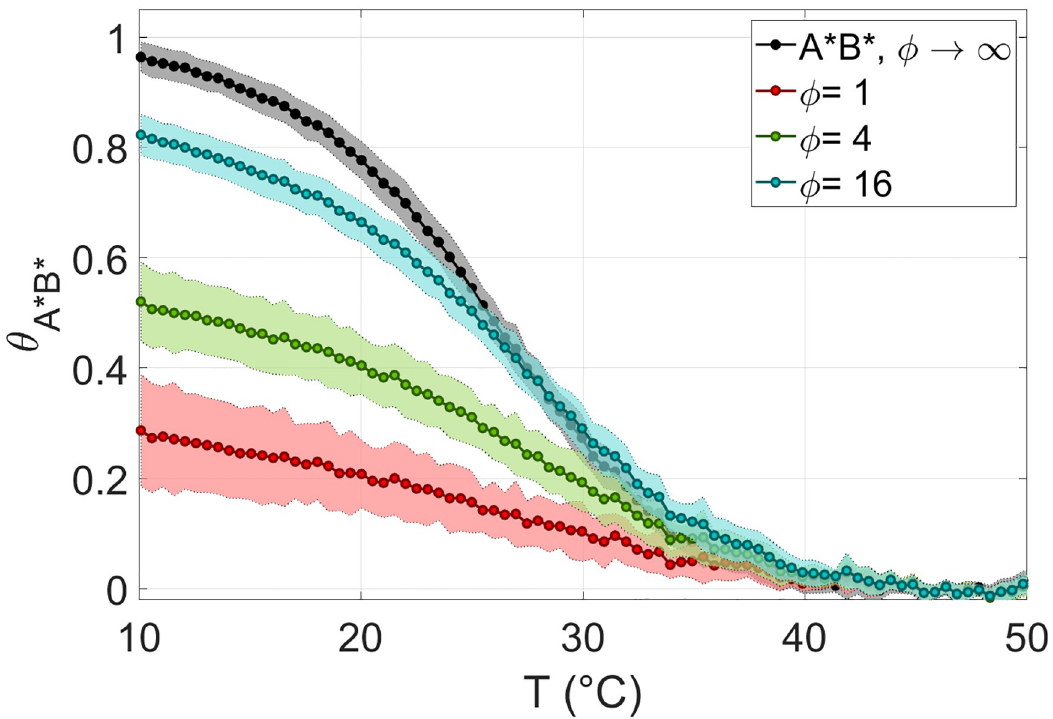
Fig 4. Probability of defectless duplexes in rsDNA. θ = 0.15 M . Colors correspond to different values of the stoichiometric ratio ϕ between the probes A � / B � and rsDNA strands. Black data is the melting curve of a neat A � B � solution (without rsDNA). In all experiments c an average over 5–10 replications of the experiment. The corresponding standard deviation is reported as shaded regions.